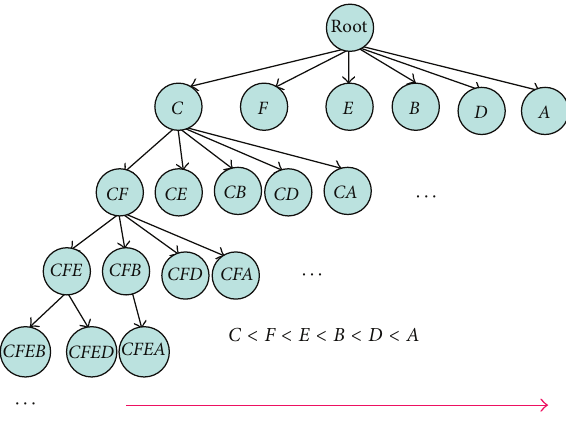
Figure 2: The enumeration